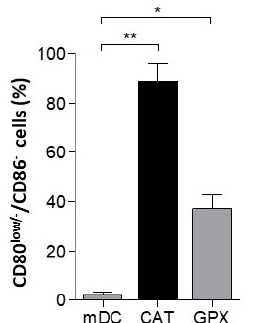
Figure 4. Catalase independent H 2 O 2 depletion by GPX impairs CD80/86-upregulation throughout